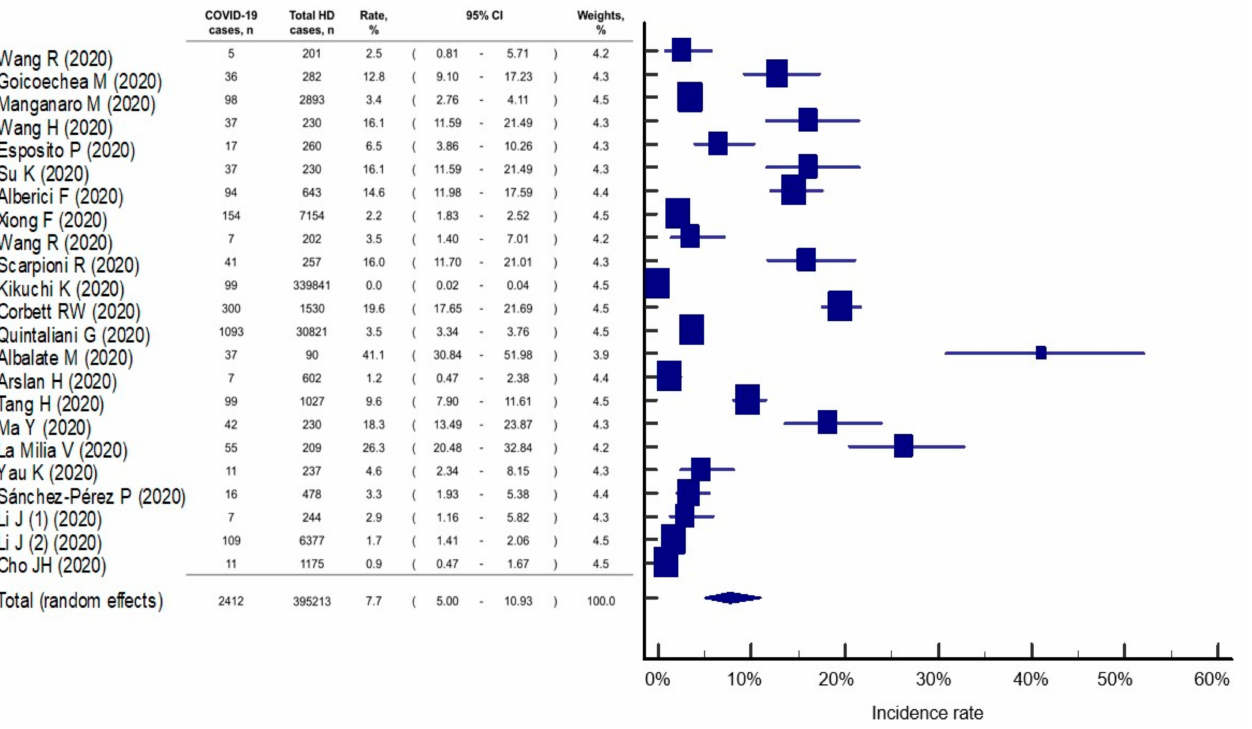
Figure 2. Incidence rate of COVID-19 infection in patients with hemodialysis. The study of Li J et al [13]. reported two independent cohorts that were analyzed separately for meta-analysis. HD, hemodialysis; CI, confidential